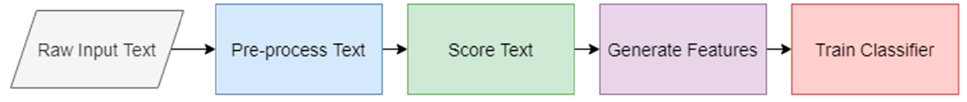
Figure 1. Procedural diagram of the processes used in automatic text classification approaches, where rhomboids represent data and rectangles represent processes.